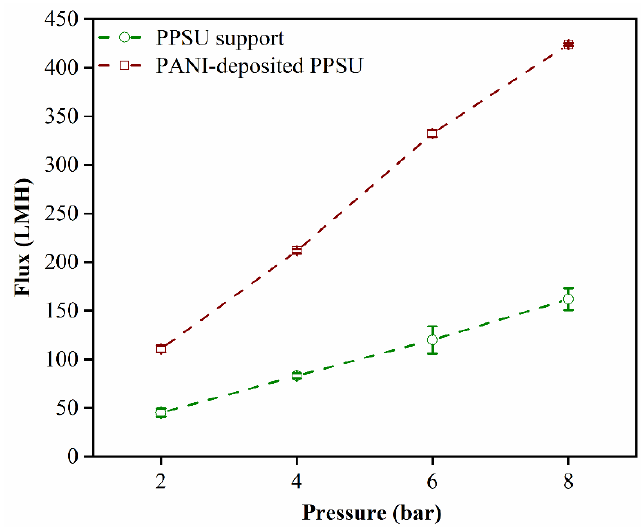
Figure 7. Permeability of the membranes to pure water as a function of pressure.